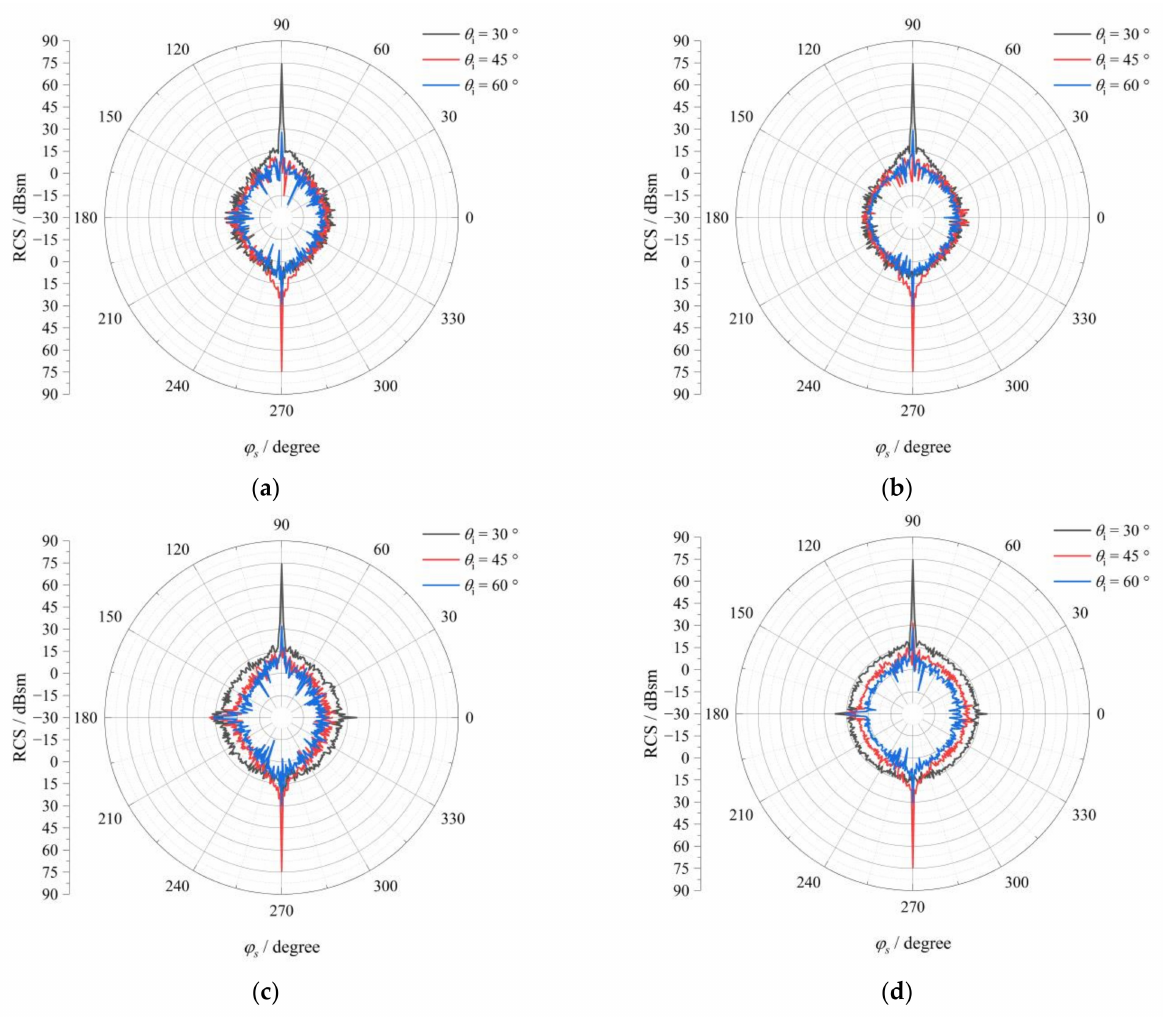
Figure 18. Monostatic RCS simulation results: ( a ) canyon, HH-polarization; ( b ) canyon, VV- polarization; ( c ) valley, HH-polarization; ( d ) valley, VV-polarization.